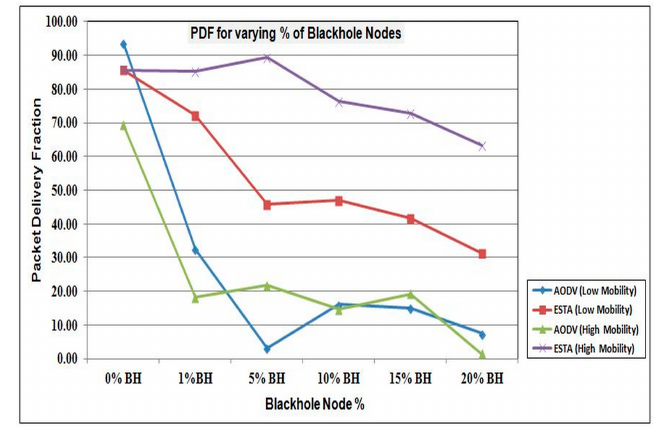
Figure 10. PDF for varying % of blackhole nodes and mobility.